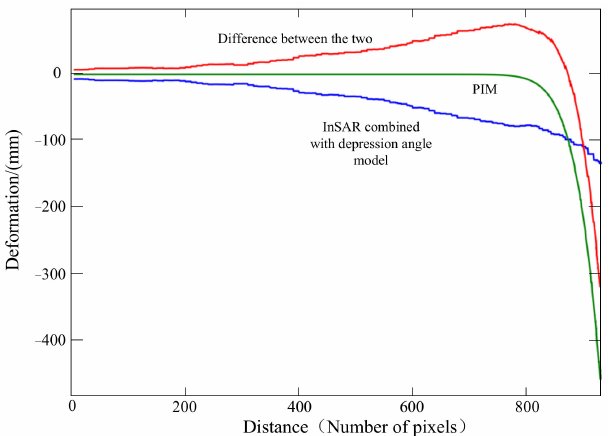
Figure 17. Comparisons of the deformation calculated by different methods.